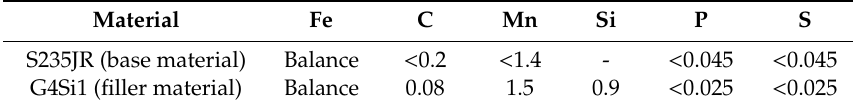
Table 1. Nominal chemical composition of the base material and the filler material (wt%).